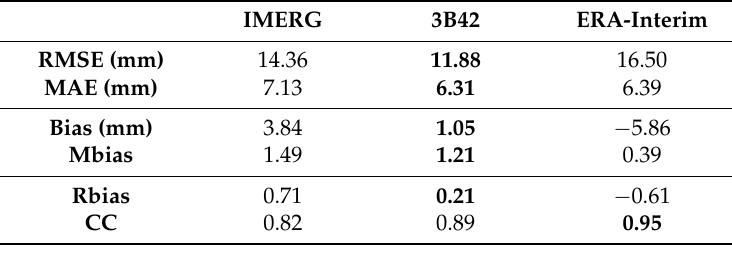
Figure 9. Bushehr monthly precipitation (mid-March 2014 to February 2015). Table 10. Statistical indices of monthly precipitation in Kermanshah area (mid-March 2014 to February 2015).